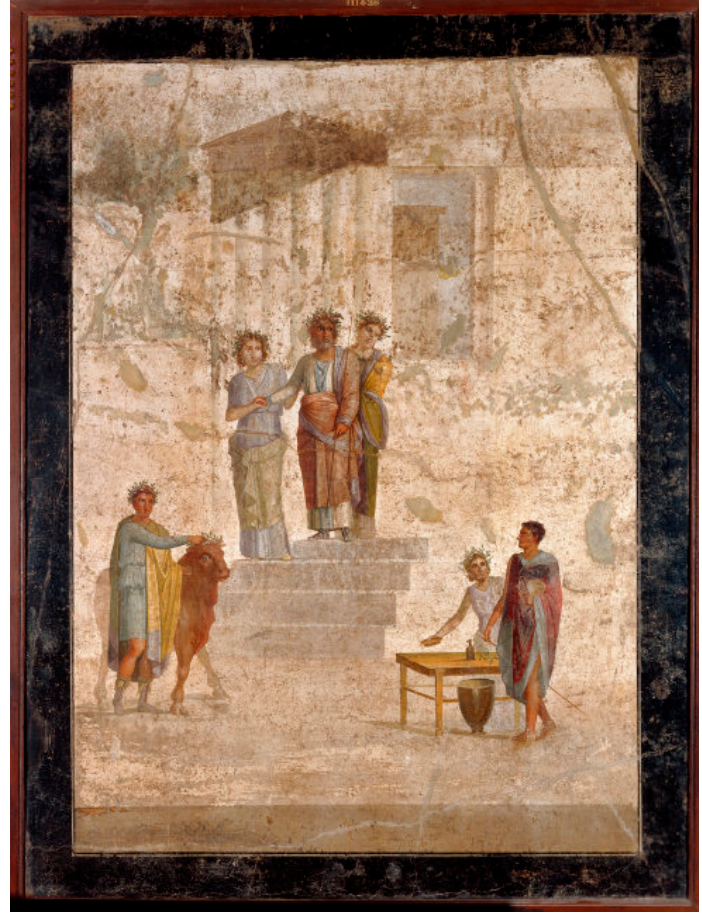
Figure 7. Jason and Pelias, Room F, House of Jason, Pompeii. Fotografica Foglia. Museo Archeologico Nazionale di Napoli, MANN 111436. Scala/Art Resource, NY. Used by Permission. Nazionale di Napoli, MANN 111436. Scala / Art Resource, NY. Used by